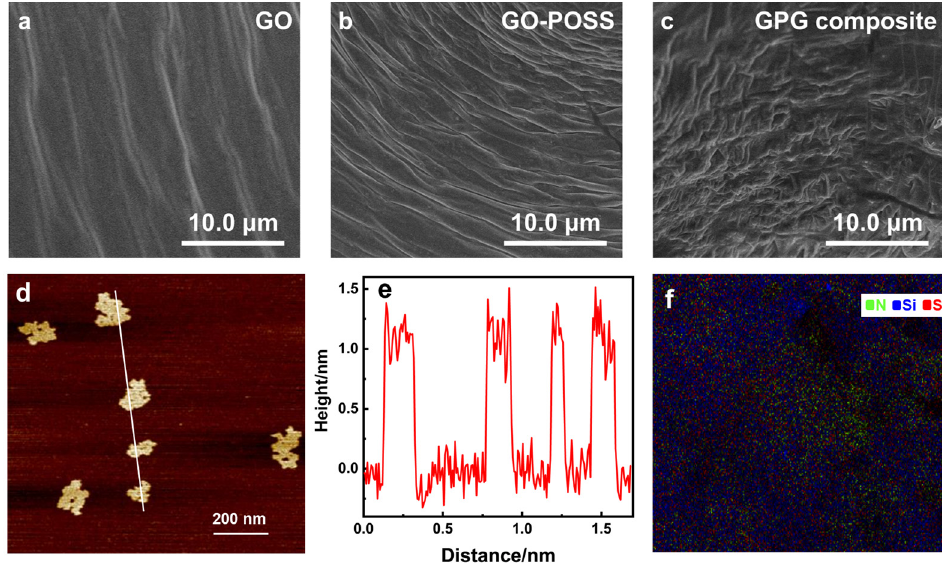
Figure 2. SEM images of ( a ) GO, ( b ) GO–POSS, and ( c ) GPG composite. ( d ) AFM image and ( e ) height profile of GO-POSS. ( f ) EDS mapping of GPG composite .